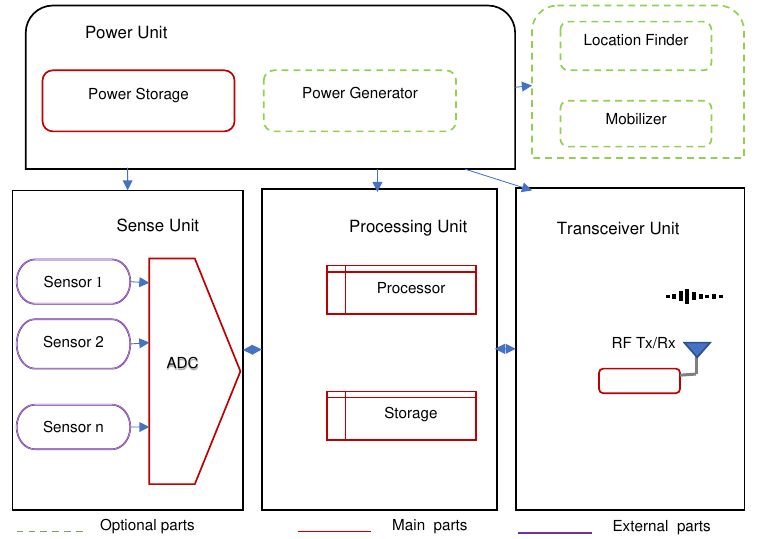
Figure 8. Elementary components of typical sensor node in a WSN (ADC: Analog-Digital-Converter; RF: Radio Frequency; Tx/Rx: